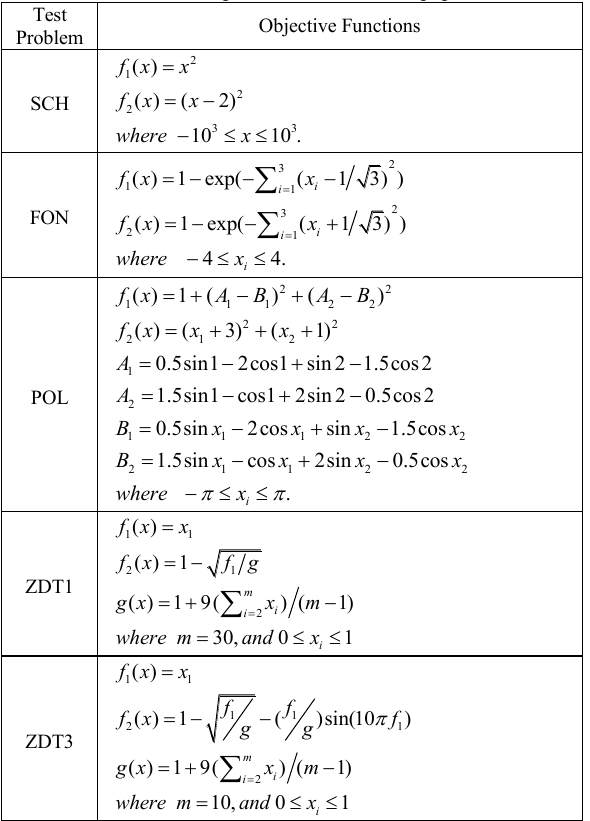
Table 1 . Test problems used in this